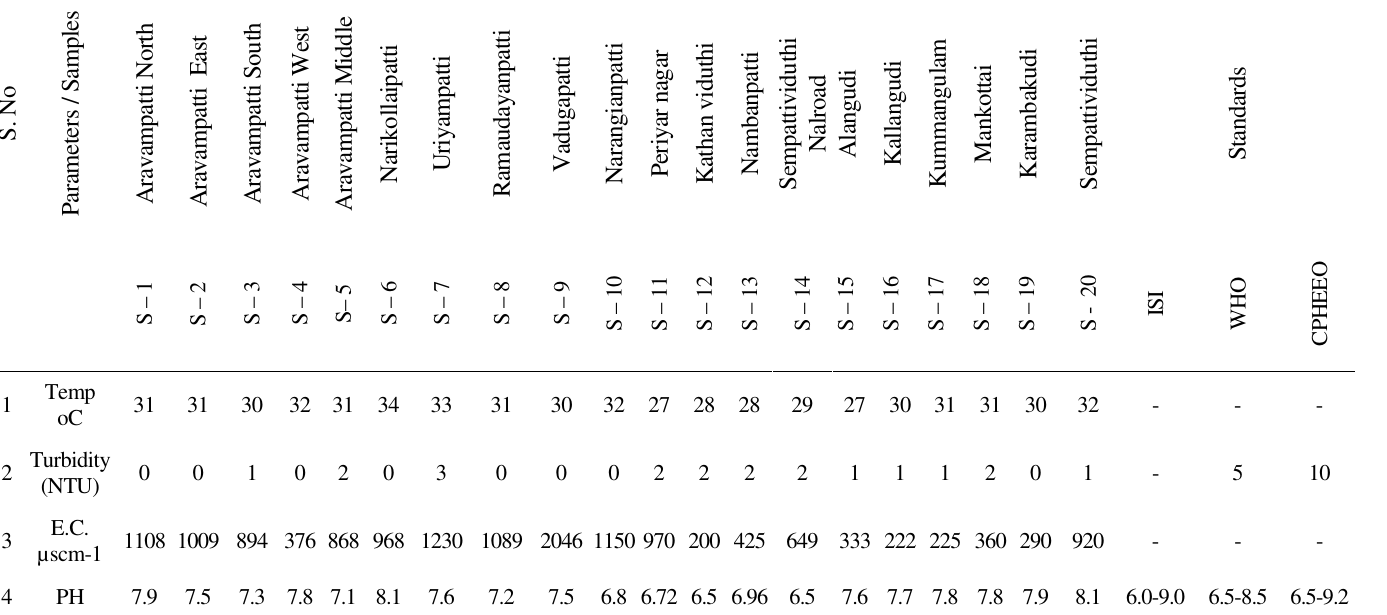
Table 1. Physical parameters of water samples collected in and around Kandarvakottai and Karambakudi areas.